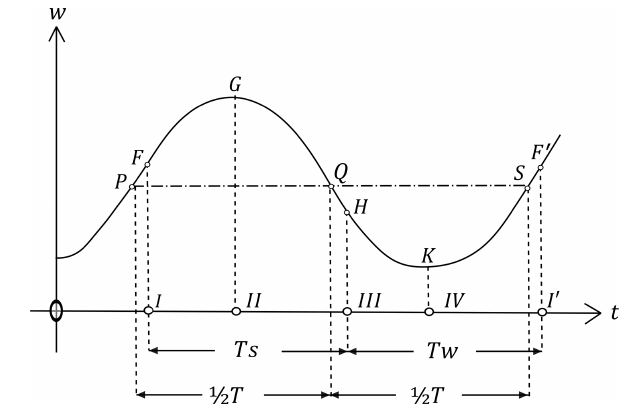
Figure 5. The annual march of the irradiation for any arbitrary lat- itude. Reprinted from Kanon der Erdbestrahlung und seine Anwen- dung auf das Eiszeitenproblem (p. 272) by Milankovitch (1941), Royal Serbian Academy Special